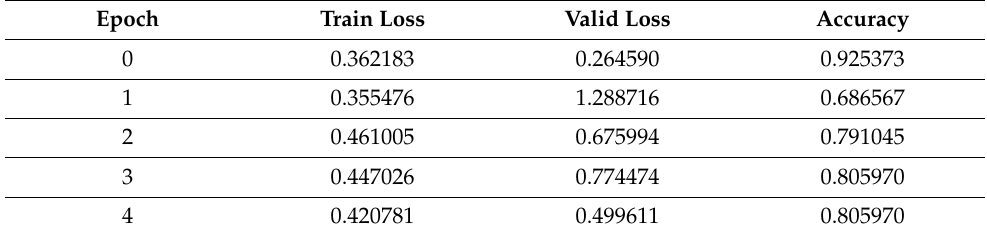
Table 3. Performance results of the fastai LSTM model.